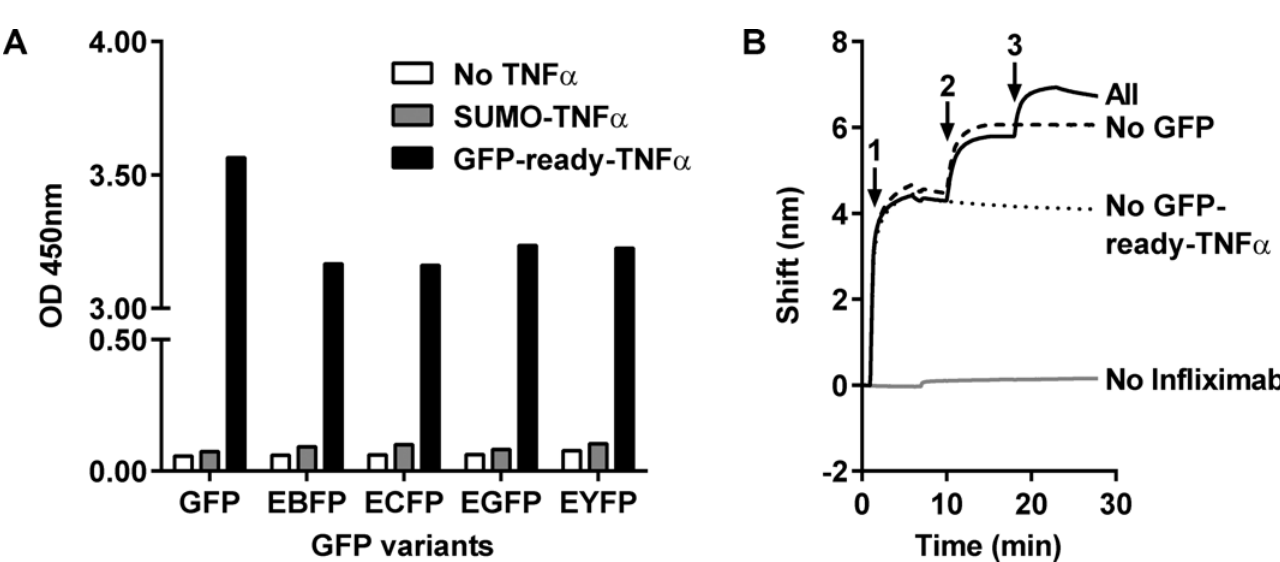
Fig 6. Binding of TNF α fusions to anti-TNF α antibody and GFP variants. Binding of GFP variants to TNF α fusions, measured by ELISA or interferometry with immobilized anti-TNF α antibody, Infliximab. (A) ELISA with no TNF α fusion (white bars), SUMO-TNF α fusion (grey bars) or GFP-ready-TNF α fusion (black bars) captured in plate wells (n = 3). (B) Interferometry kinetic binding profile with loading of Infliximab (step 1), GFP-ready-TNF α fusion (step 2) and GFP (step 3). Besides the sample with all bound partners (plain line), controls without GFP, GFP-ready-TNF α or Infliximab were also measured (dashed line, dotted line and grey line, respectively).